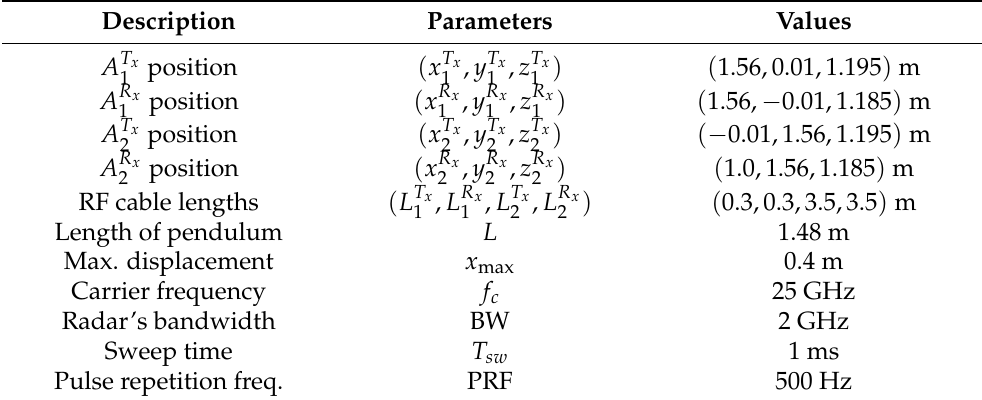
Table 1. MIMO experimental